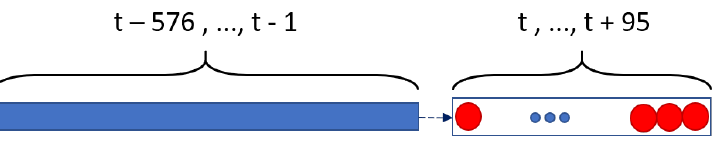
Figure 6. Input and target definition.